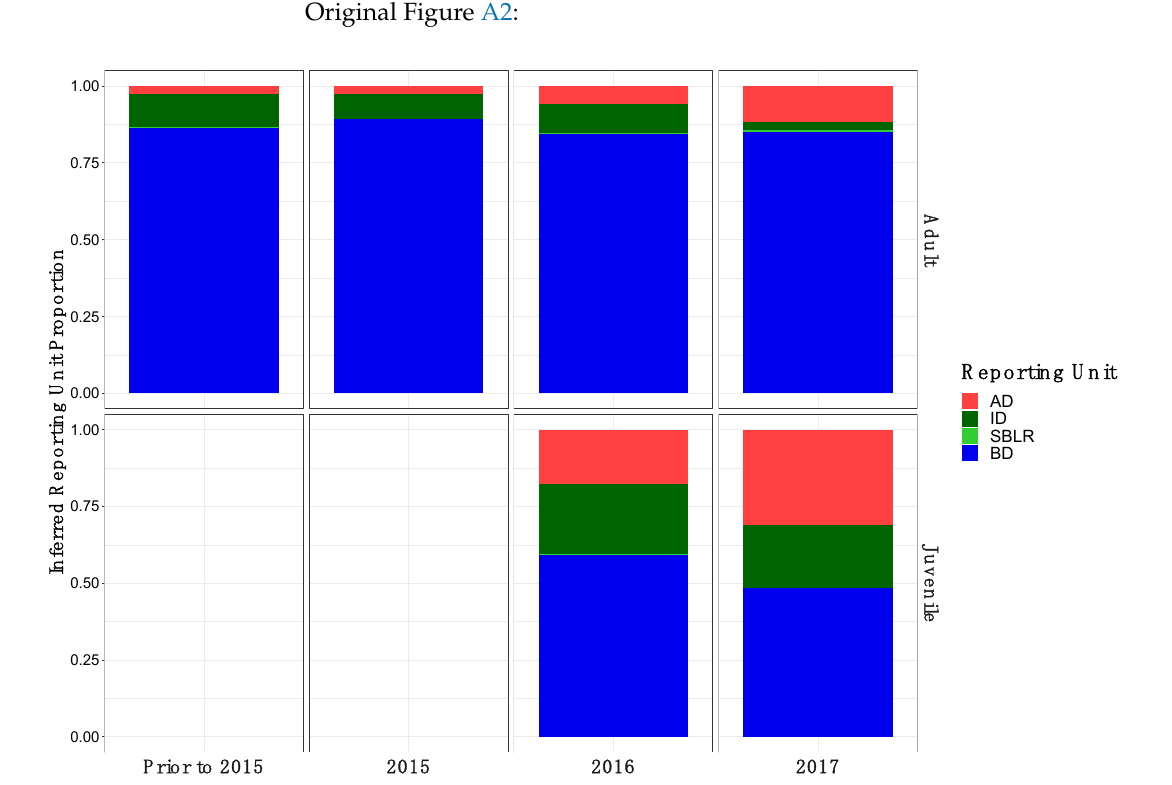
Figure A1. Inferred proportion of genetic ancestry from each of the four inferred populations across recolonizing adult and juvenile steelhead smolt life history cohorts from the GSI analysis (ii). Colors are representative of the inferred population. The bottom x axis divides life history cohorts tempo- rally and the right y axis divides them by life history stage. Relative proportions of genetic ancestry from ID populations were greater in adult life history cohorts in GSI analysis (ii) compared to GSI analysis (i) and GSI analysis (iii).